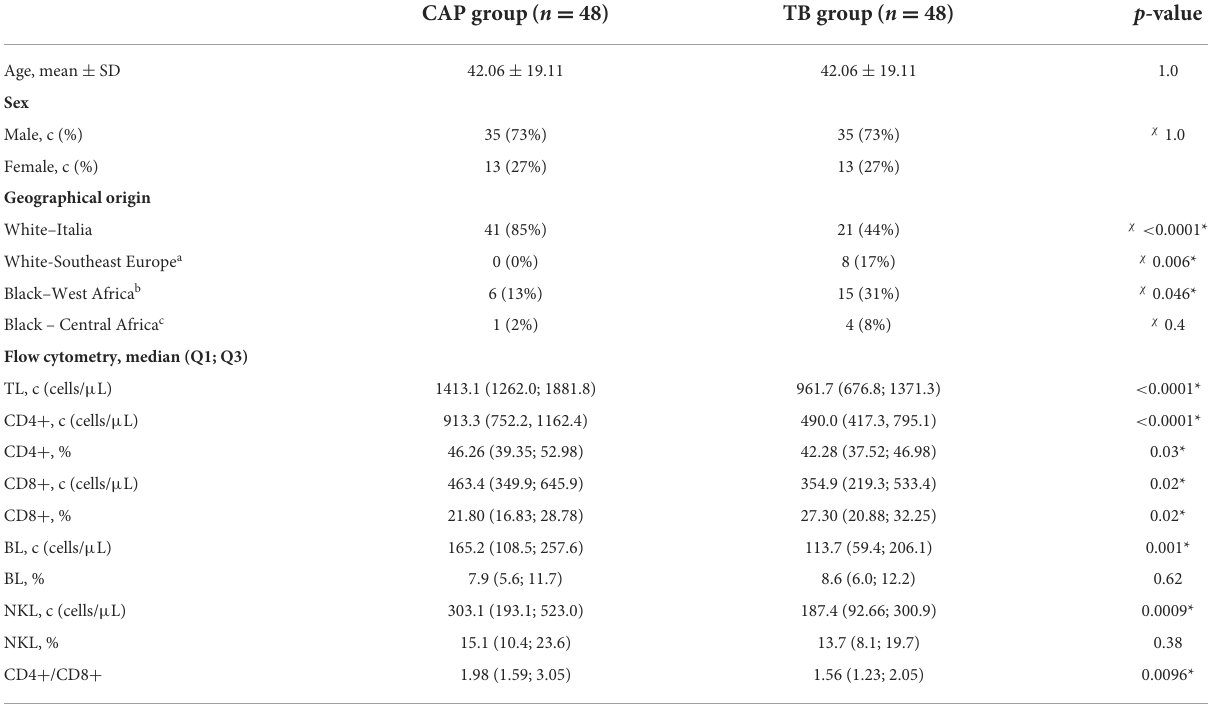
TABLE 1 Demographic characteristics and flow cytometry results in the control group and in the TB group.